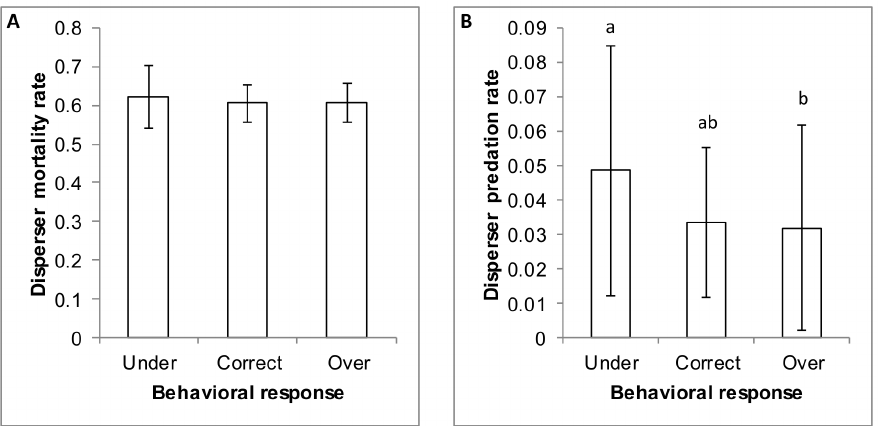
Figure 2. Eastern chipmunk mortality rate. Mean ( 6 1 SD) A) overall mortality rate and B) predation-specific mortality rate for virtual chipmunks with varying levels of response to simulated predation risk.